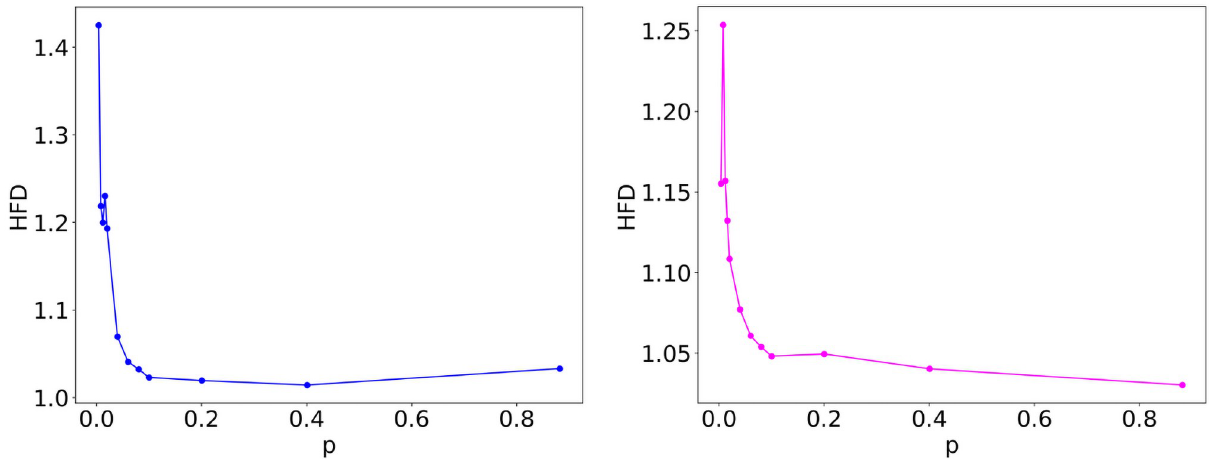
Fig 4. HFD of WS ensemble potentials. Higuchi fractal dimension (HFD) of the ensemble potential V m over 100 graphs with N = 500 nodes and average degree c , resulting from a WS model with rewiring probability p probability p = c /( N −